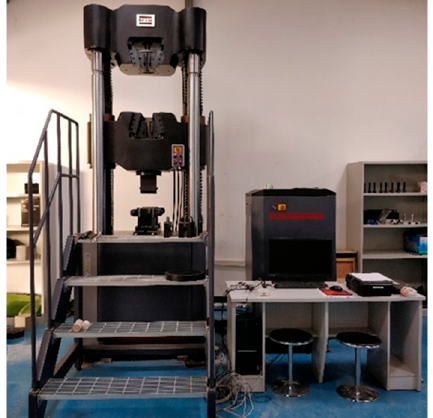
Figure 1. MTS universal testing machine.